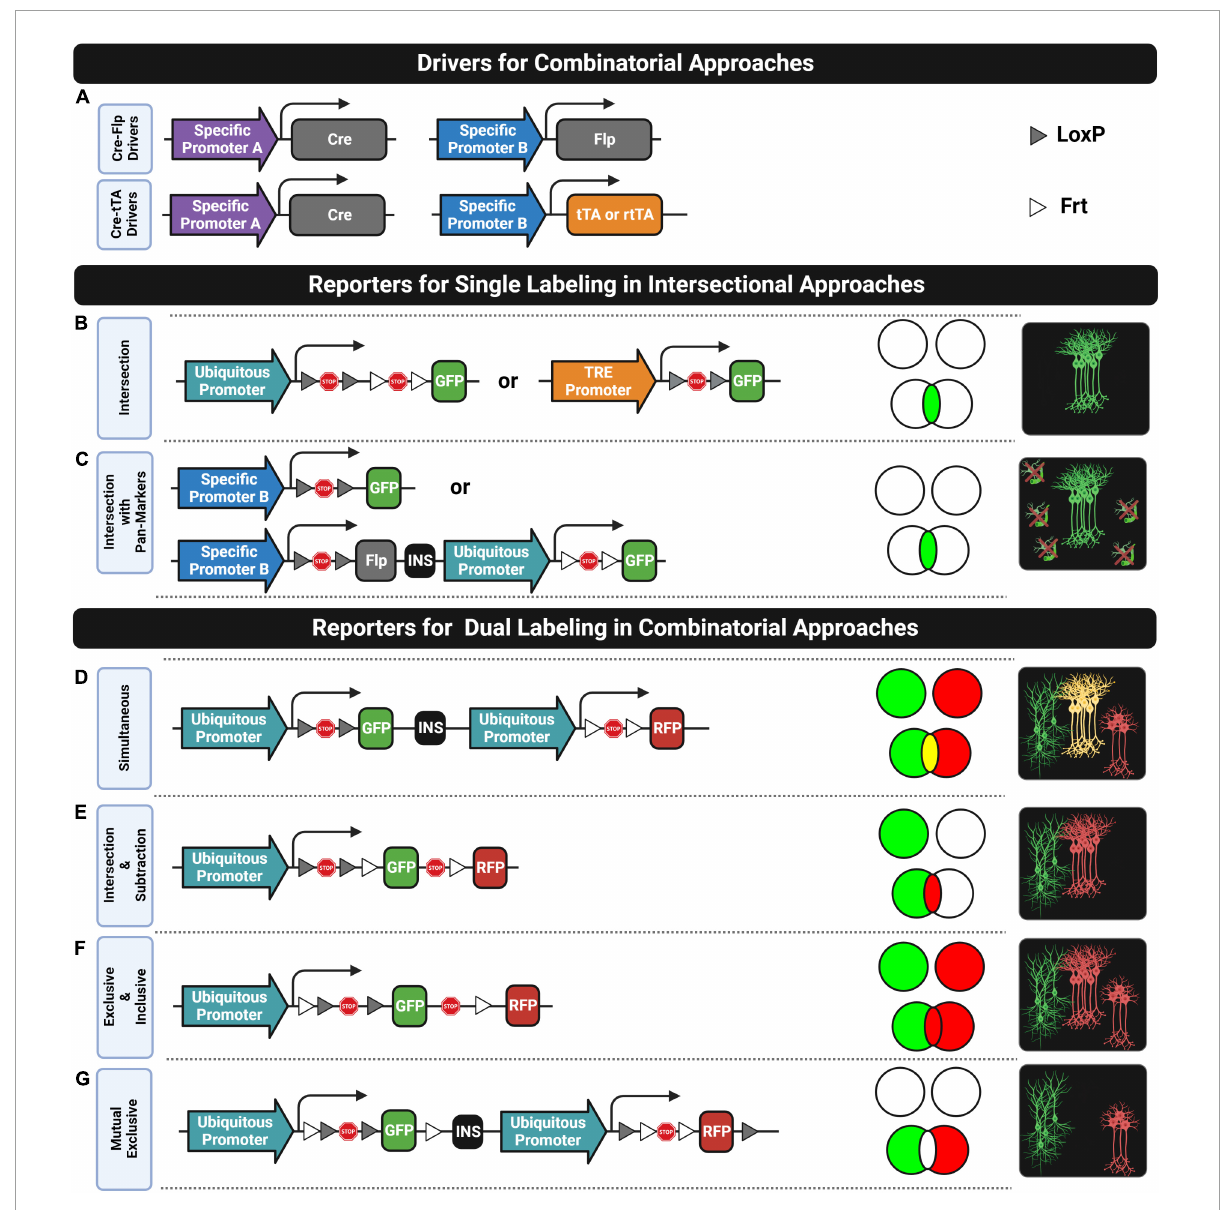
FIGURE5 Combinatorial strategies. (A) Two driver combinations (Cre-Flp and Cre-tTA) widely used for labeling cell subtypes based on two genes. (B,C) Reporter designs compatible with single labeling in intersectional approaches that require generating triple transgenic (B) or double transgenic (C) mice. (D–G) Reporter designs compatible with dual labeling in combinatorial approaches. Venn diagrams indicate the labeling subsets for each reporter design in two situations: when the two genes are mutually exclusive in all cells (top) and when their expression overlaps in some subset of cells (down). Rightmost diagrams represent the labeling pattern only in the overlapping gene